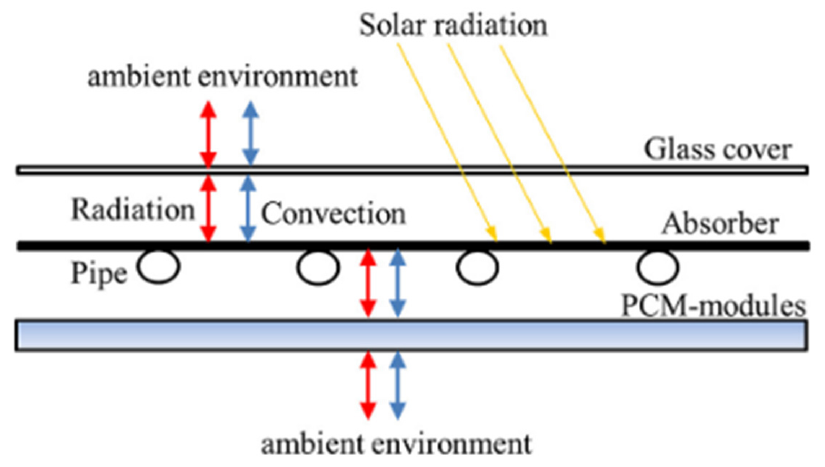
Figure 16. The illustration of the heat transfer mode in the FPC-PCM. Adapted with permission from ref. [131] 2019 Zhou et al. Table 6. A few studies on the integration of TES systems on solar collectors.